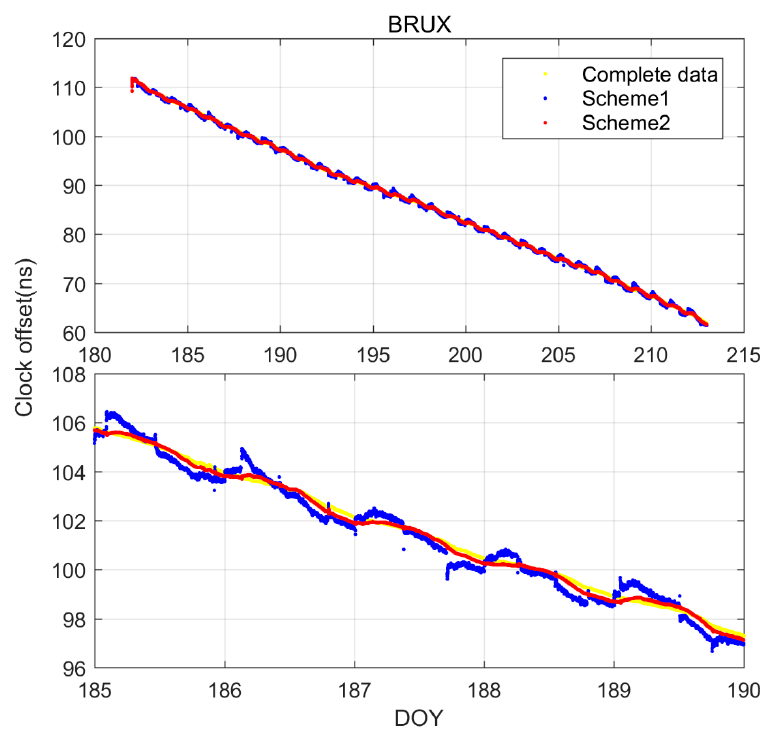
Figure 5. Clock offset time series for scheme 1 ( blue ) and scheme 2 ( red ) when a data interruption of 10 min occurs; the yellow colour represents the solutions of the complete data using the between-epoch constraint model; the bottom figure is a partial amplification of the top figure. Appl. Sci. 2019 , 9 , x FOR PEER REVIEW 10 of 17